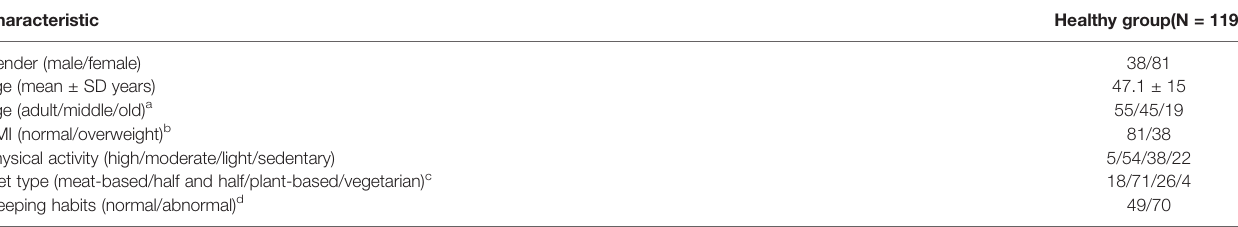
TABLE 1 | Anthropometric and demographic data of healthy Taiwanese cohort.